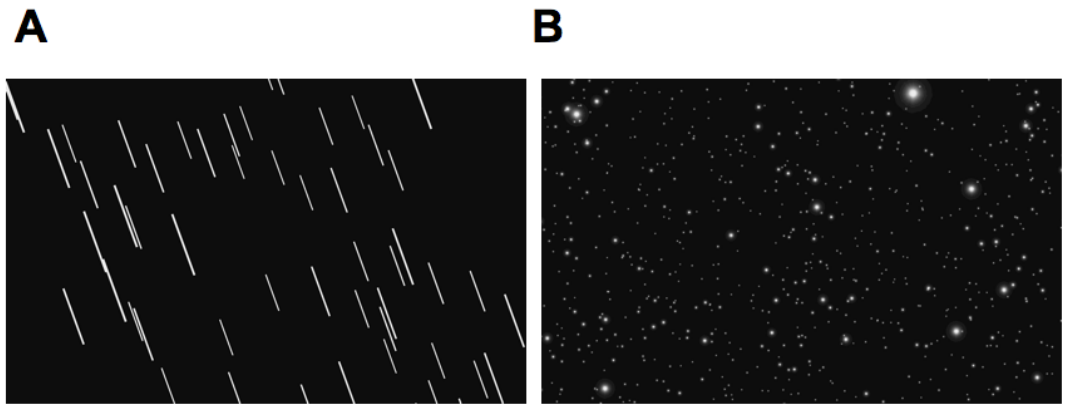
Figure 6. Screenshots of ( A ) the multiple-line stimulus and ( B ) dot stimulus.